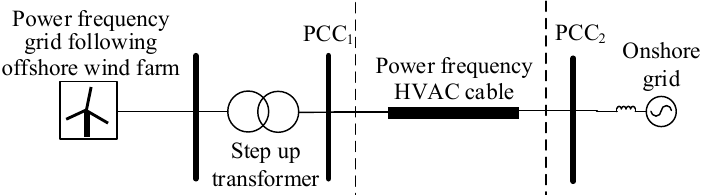
Figure 1. Scheme 1: Power frequency AC transmission scheme for power-frequency grid-following offshore wind farms.